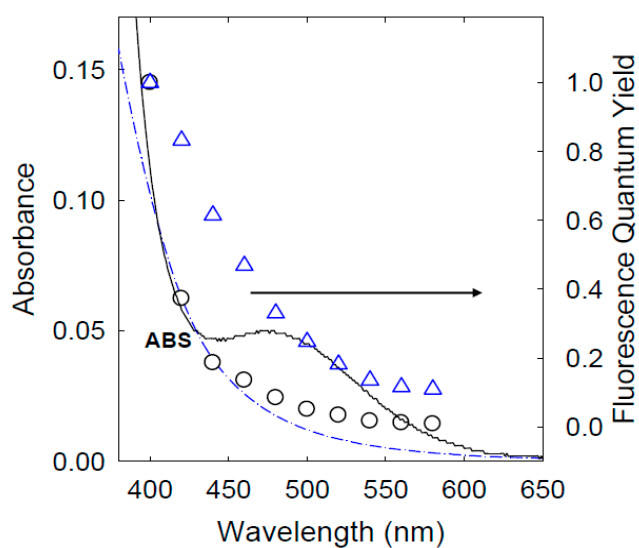
Figure 4. Fluorescence quantum yields at different excitation wavelengths of the as-supplied MilliporeSigma sample solution ( ○ ) are compared with those of EDA-CDots ( ∆ ), where the yields are normalized against the values at 400 nm excitation of 5.9% for the former and 24% for the latter. Their absorption spectra (solid line for the former, and dash-dot-dash line for the latter) are also shown.